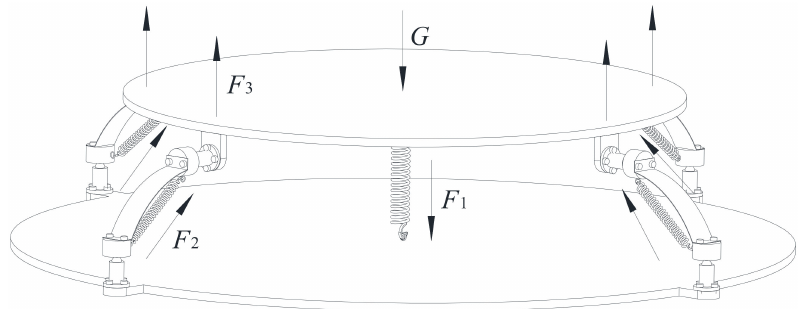
Figure 11. Schematic diagram of initial load condition.